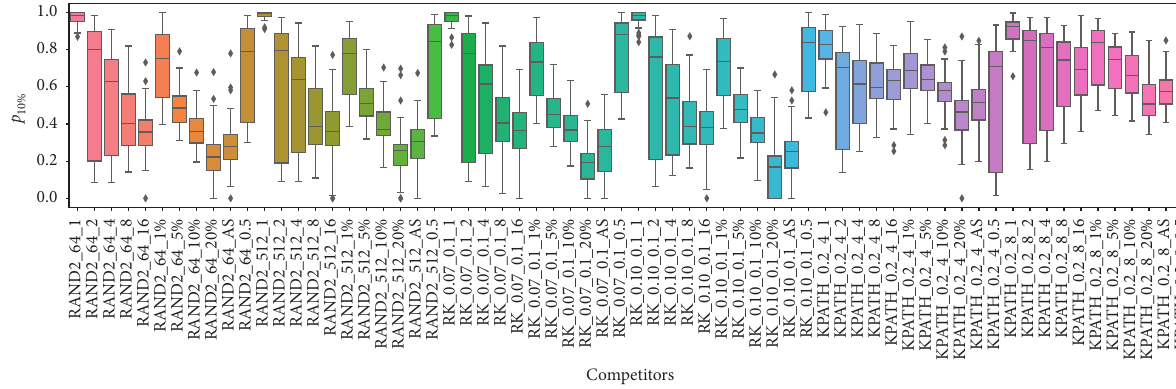
Figure 7: Distribution of 10% GCC reduction of 66 competitors on 45 random networks. Table 4: Results on ER networks with 300 nodes with generator parameter p � 0 . 02, using six approximation algorithms and setting k � 1.